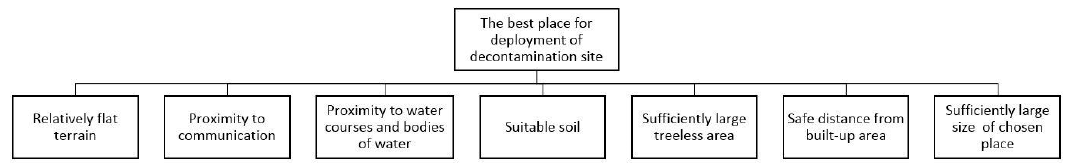
Figure 3. Hierarchy of the conditions of the process scheme.